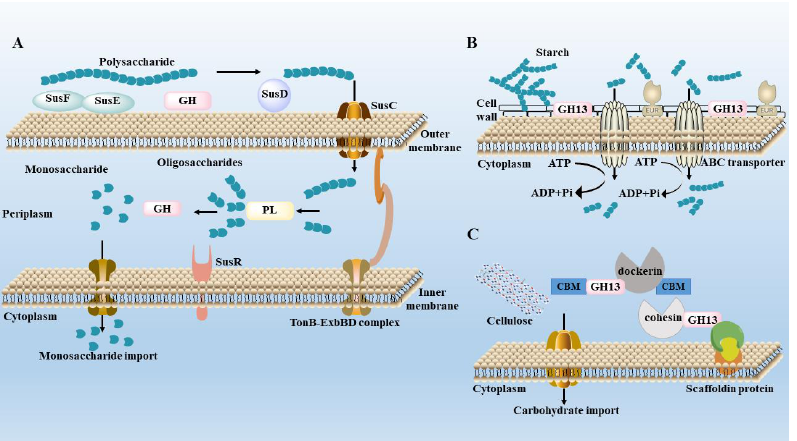
Figure 2. Degradation mechanisms of gut microbiota. ( A ) Starch utilization system (Sus) in Bac- teroides thetaiotaomicron . ( B ) ATP-binding cassette ( A – C ) transport system in Eubacterium rectale . ( C ) The multi-enzyme complexes system in Ruminococcus champanellensis .